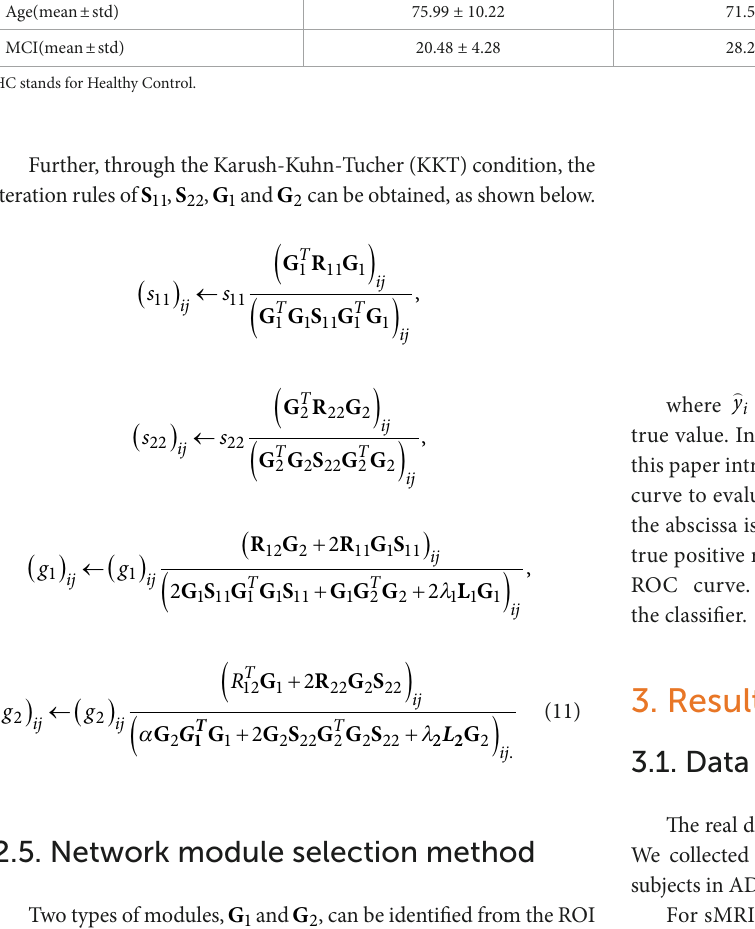
TABLE 1 Information about the samples included in the analysis in this paper. Groups AD MCI HC 25